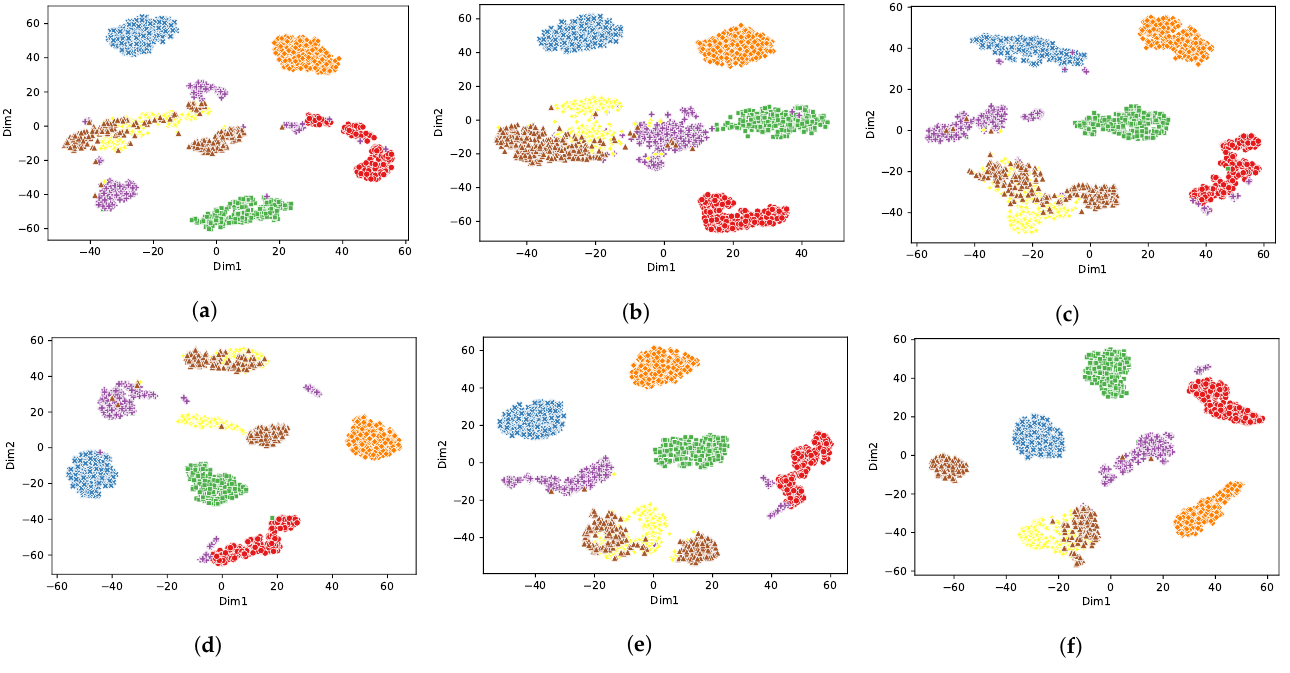
Figure 7. Visualization of learned features at the final GAP layer of ( a ) ResNet-Sigmoid, ( b ) ResNet- PReLU, ( c ) ResNet-ReLU, ( d ) ResNet-ELU, ( e ) ResNet-SELU, and ( f ) ResNet-SofT when the number of ResBlocks equals 9 and SNR equals − 2 dB.